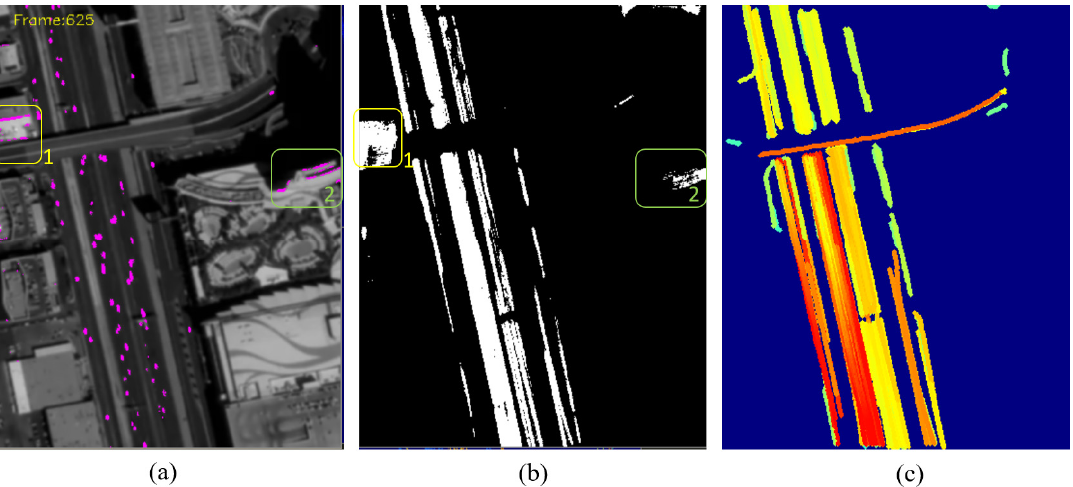
Figure 16. Comparison of the tracklets extracted using different methods. ( a ) The initially detected candidates of moving objects; ( b ) Motion trajectories extracted by accumulation; ( c ) Tracklets extracted using our method, in which incorrect tracklets in the rectangles in ( b ) were removed.